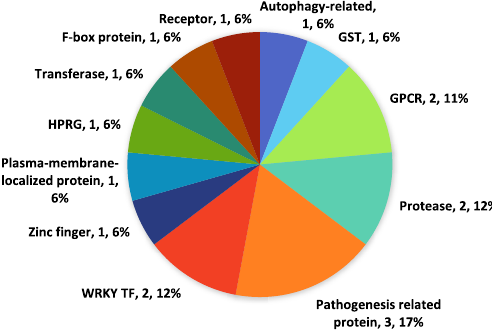
Fig. 6. Classification of defence related genes in qLBL5 according to functional